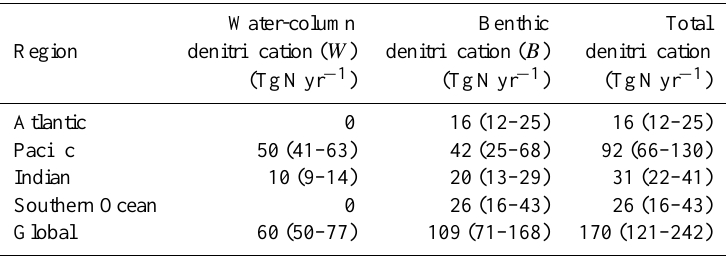
Table 1. Integrated denitrification rates by ocean basin. Median rate is given, with range in parentheses. The range includes uncertainty due to uncertainty in the isotopic enrichment factors of fixation and benthic denitrification, and in the parameterization of dissolved organic matter. Southern Ocean is south of 34 ◦ S. Global rates also include contribution from benthic denitrification in the Arctic Ocean and the Mediterranean